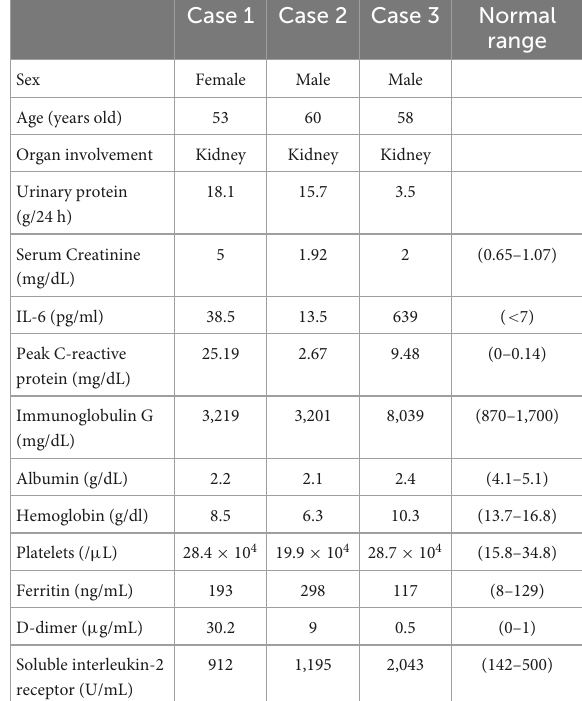
TABLE 1 Clinical markers of the